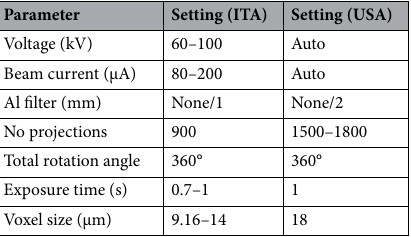
Table 2. Micro-CT setups. Micro-Computed Tomography setups used for scanning both Italian and American specimens of primate external genitals (auto = set